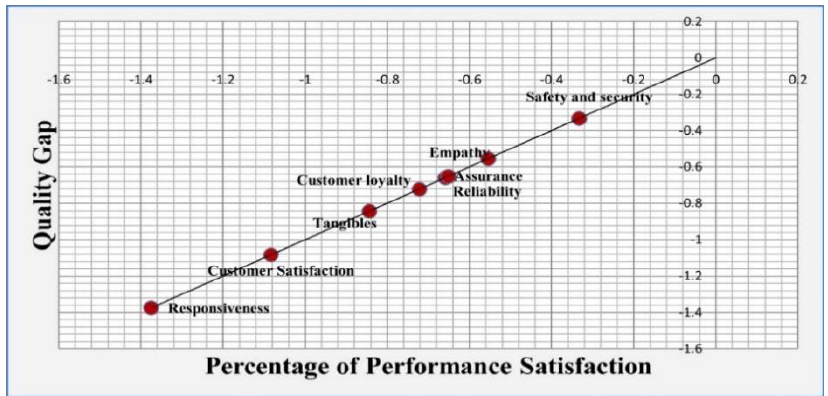
Fig. 4. Gap quality analysis of reverse support services the studied airline industry companies.